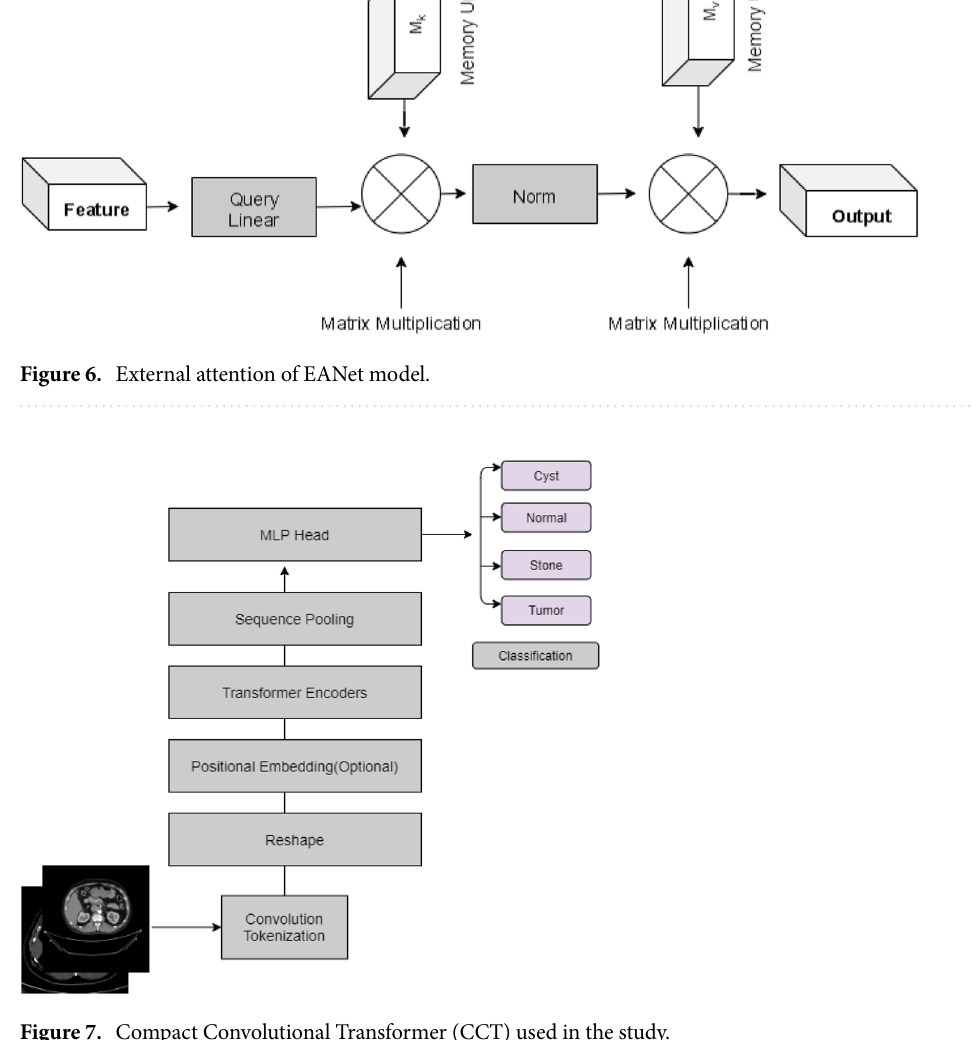
Figure 7. Compact Convolutional Transformer (CCT) used in the